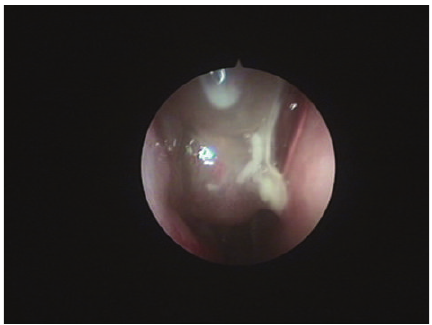
Figure 2: Right nostril. Polyp relapse.